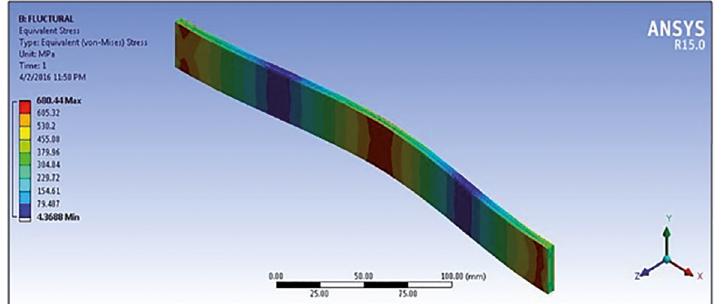
Figure 15: Stress distribution due to flexural loading